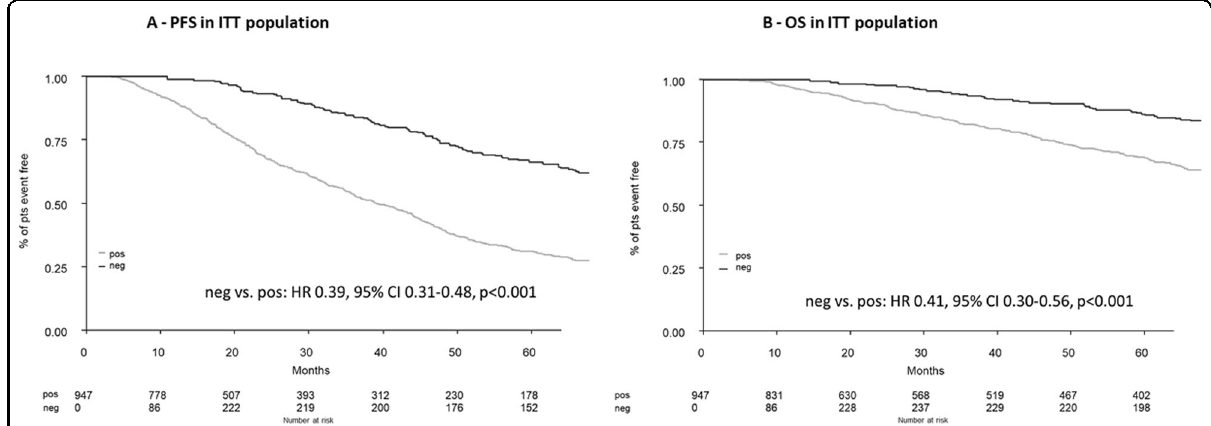
Fig. 2 PFS, progression-free survival; OS, overall survival; ITT, intention to treat; pos, positive; neg, negative; pts, patients. A Progression- free survival in the intention-to-treat population. B Overall survival in the intention-to-treat population.